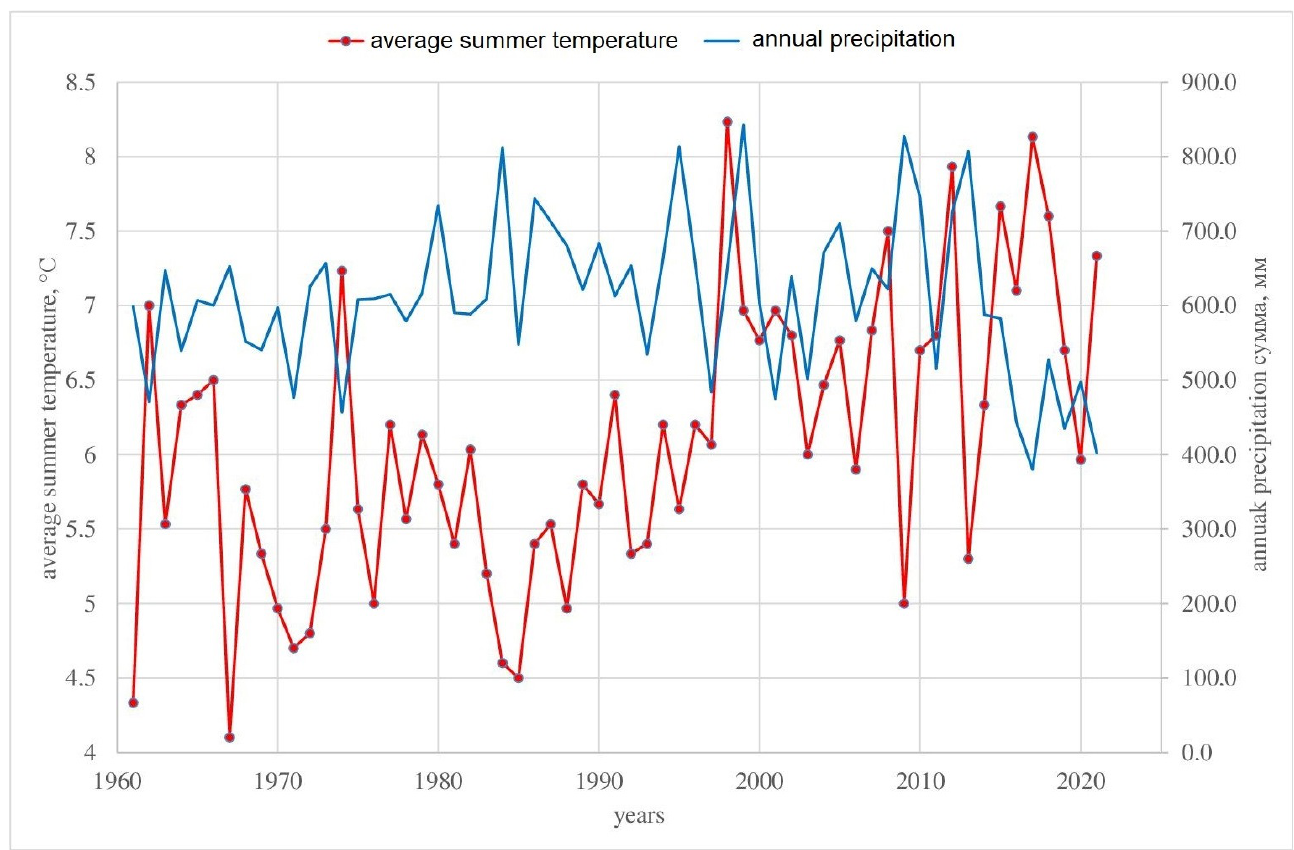
Figure 12. Long-term changes in the average summer temperature and the total precipitation according to the Kara-Turek meteorological